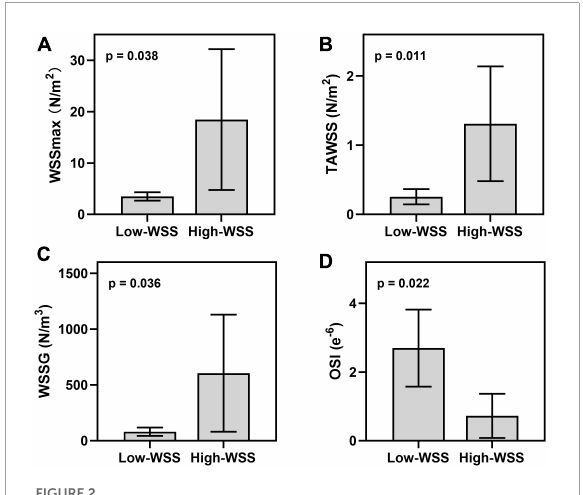
FIGURE2 Hemodynamic difference between high-WSS and low-WSS groups in the aneurysms forming area. (A) Results of WSSmax. (B) Results of TAWSS. (C) Results of WSSG. (D) Results of